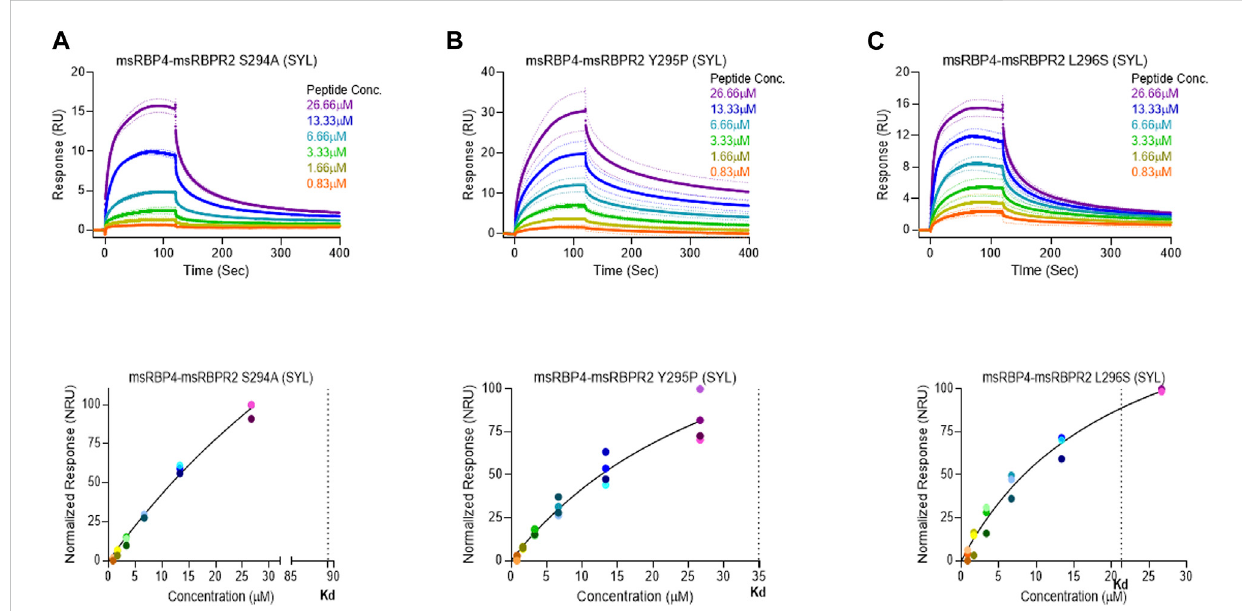
FIGURE 7 Surface plasmon resonance binding studies between mutant RBPR2 and its ligand RBP4. Binding studies using SPR between mouse RBPR2-S294A (A) , RBPR2-Y295P (B) , RBPR2-L296S (C) and immobilized mouse RBP4 protein is shown, together with the respective kinetic values ( K d ) in the bottom respective panels. The interaction levels measured in Response Units (RU) and real time plot sensorgram display the dynamics of the analysis.